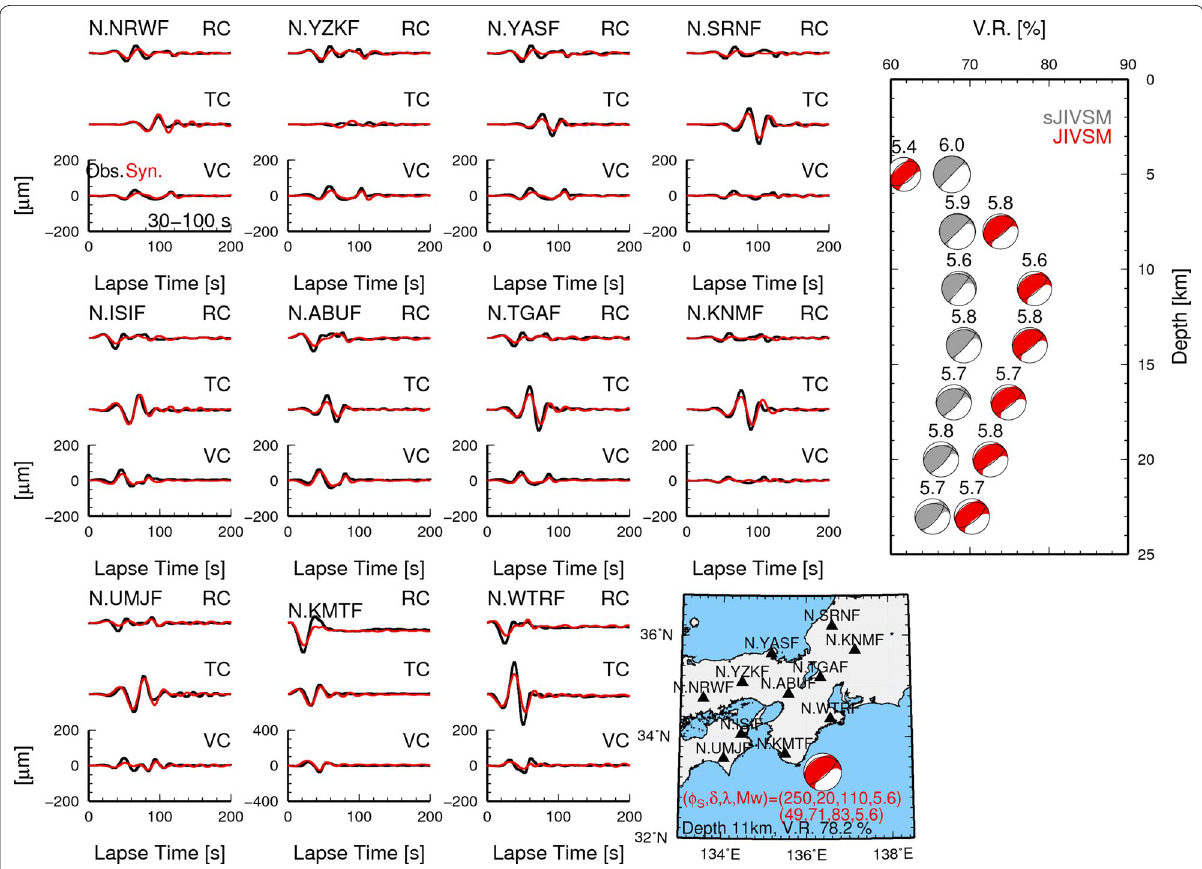
Fig. 8 Results for the MT inversion of the 2016 SE offshore Mie earthquake using the JIVSM. Black and red traces are the observed and synthetic displacement waveforms for periods of 30–100 s at 11 F-net stations, respectively. Stations used in the moment tensor inversion are shown in the right-bottom subfigure. Gray focal spheres in the right subfigure are the MT results at each depth using sJIVSM. The number above each focal sphere is the estimated Mw at each depth. Detailed parameter information for the optimal moment tensor using JIVSM is given in Table